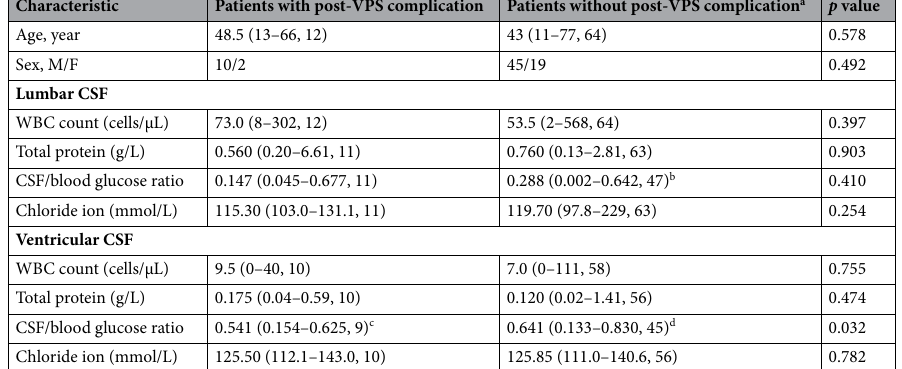
Table 4. Comparison of CSF parameters between patients with and without surgical complications. Data presented as the median [Range, n] or n. M, male; F, female. n: Number of patients who had indicated CSF detection results. a a patient who died one month after surgery due to hemorrhagic shock caused by hepatitis B virus-related decompensated cirrhosis was excluded. b,c,d 16, 1 and 11 patients lacked contemporaneous blood glucose values